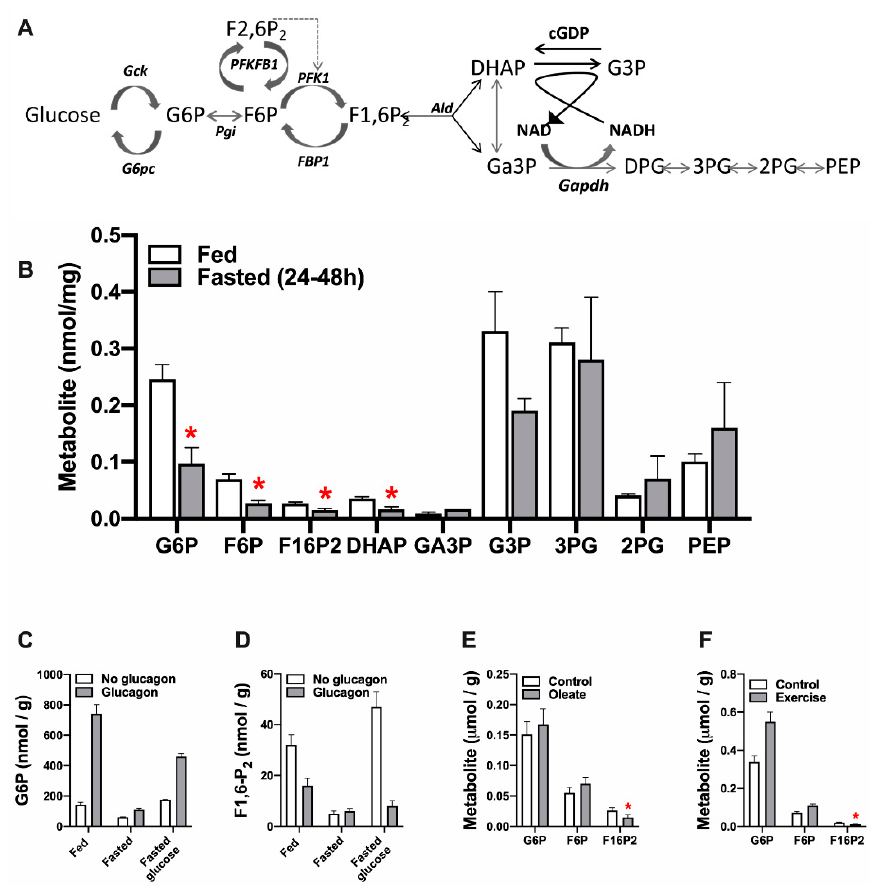
Figure 1. Liver concentrations of intermediates of glycolysis and gluconeogenesis. ( A ) Metabolic intermediates of glycolysis and gluconeogenesis. ( B ) Concentrations of key metabolites in rat liver in the fed and fasted state; data from Bergmeyer, HU [52]). ( C , D ) Liver metabolites in fed and fasted rats treated with glucose (2 g/kg, 10 min) or glucagon (1 mg/kg, 2 min); data from [53,54]. ( E ) Effects of 1 mM oleate on metabolites in hepatocytes from fasted rats, data from [55]. ( F ) Rat liver metabolites in rested and exercised rats, data from [56]. * p < 0.05 fasted vs. fed